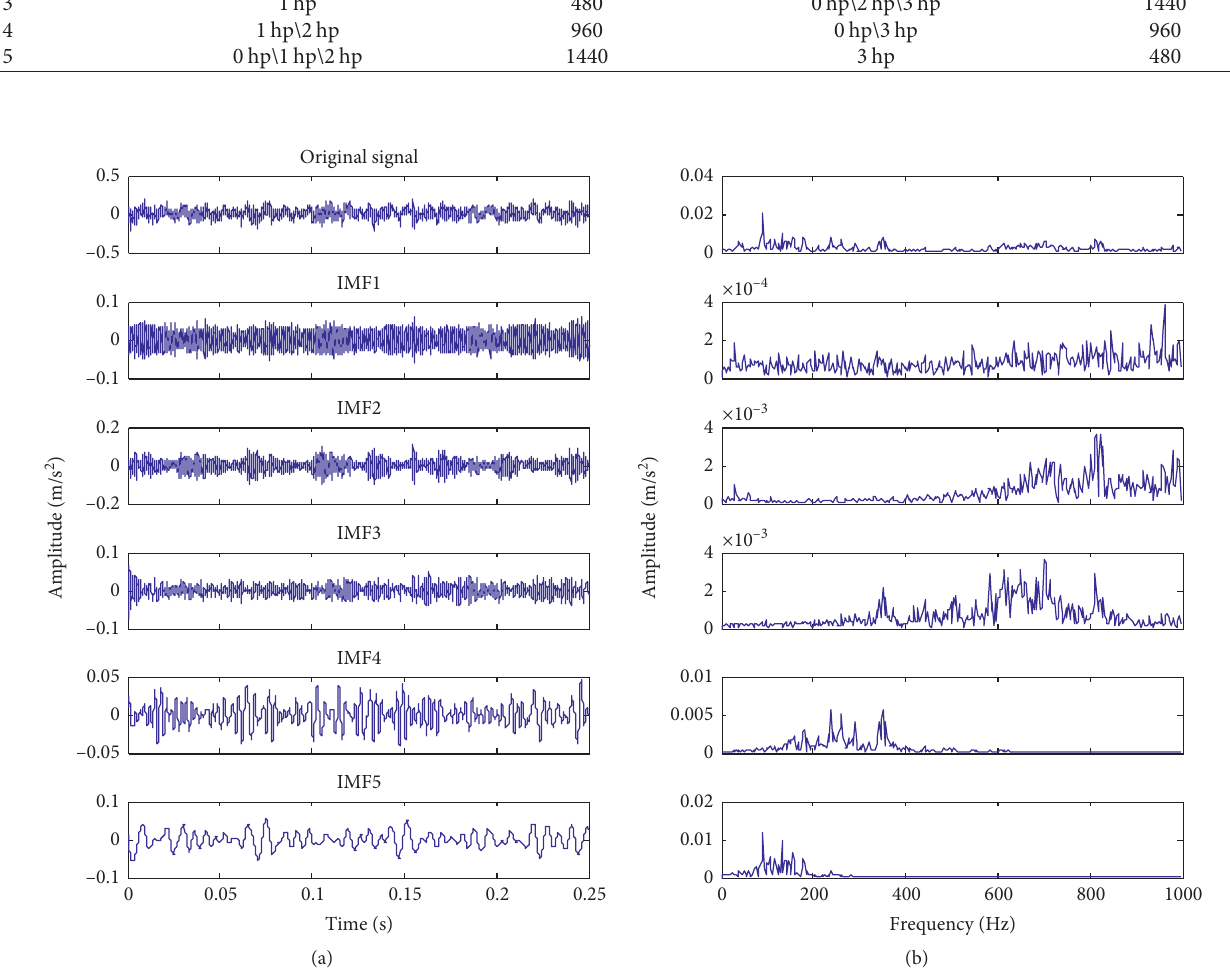
Figure 4: Decomposition results of one normal signal and the FFT amplitude